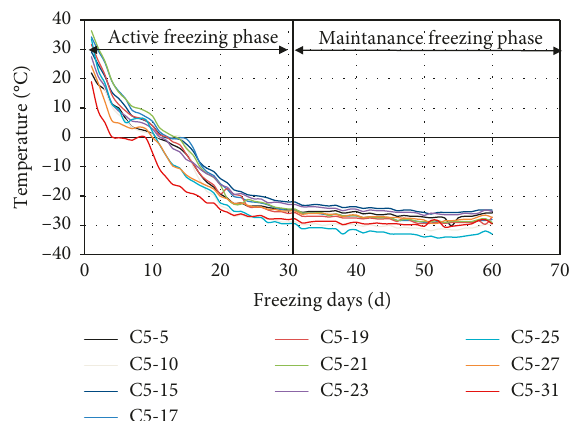
Figure 12: Curves of temperature and times at C5 temperature measuring hole.